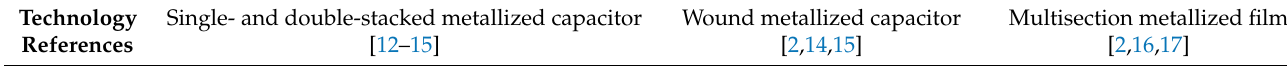
Table 3. Main review articles focusing on metallized capacitor